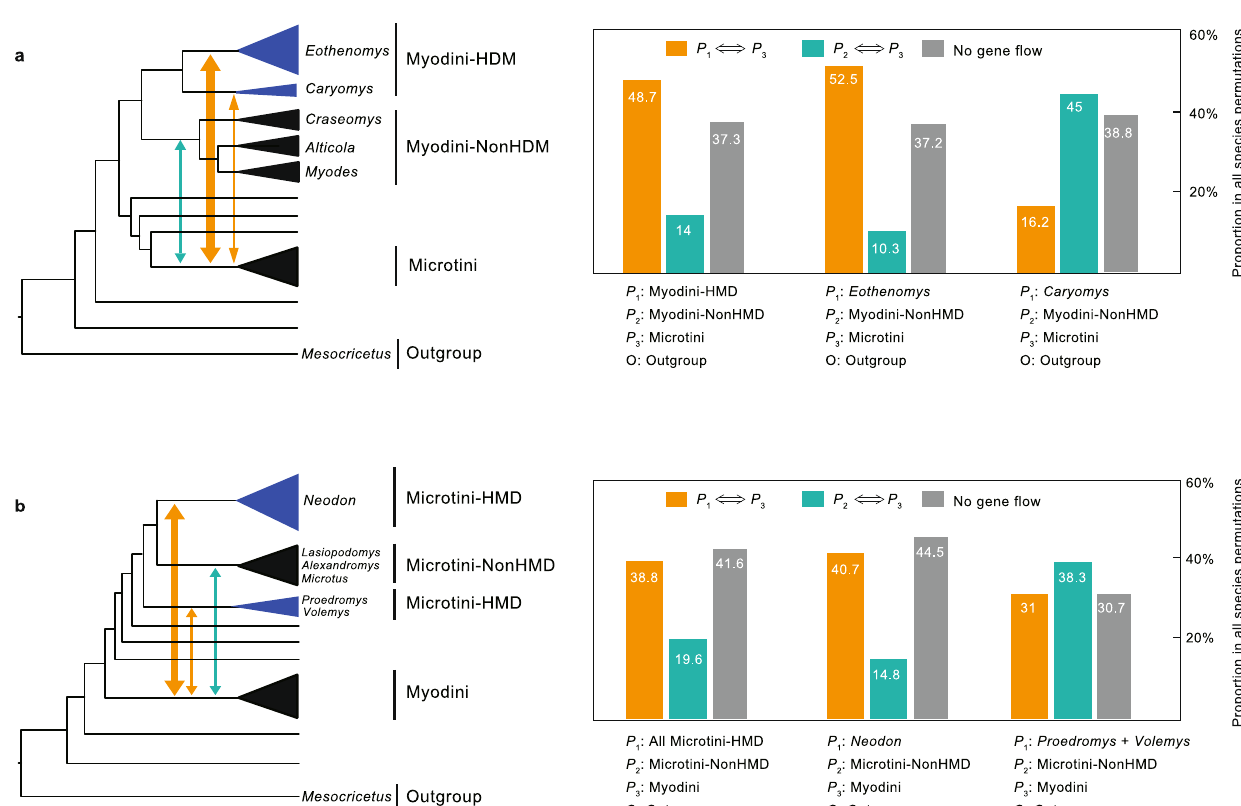
Fig. 5 Intertribal gene fl ow pattern between Microtini and Myodini. A schematic representation of Patterson ’ s D test is provided on the left for each test: HDM genera are indicated in blue, non-HDM genera are indicated in black, and gene fl ow between lineages is indicated with double-arrowed lines. a Gene fl ow test using Microtini as P 3 , the non-HDM genera of Myodini as P 2 , and different components of the HDM genera of Myodini as P 1 . b Gene using Myodini as P 3 , the non-HDM genera of Microtini as P 2 , and different components of the HDM genera of Microtini as P 1 . The histograms to the right